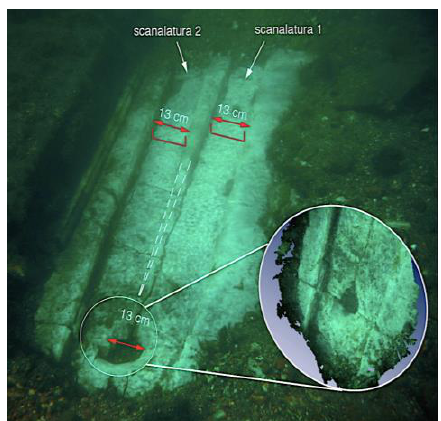
Fig. 11 - Laser scanner relief of the differential degradation of the black and white tesserae. (ISCR Archive)